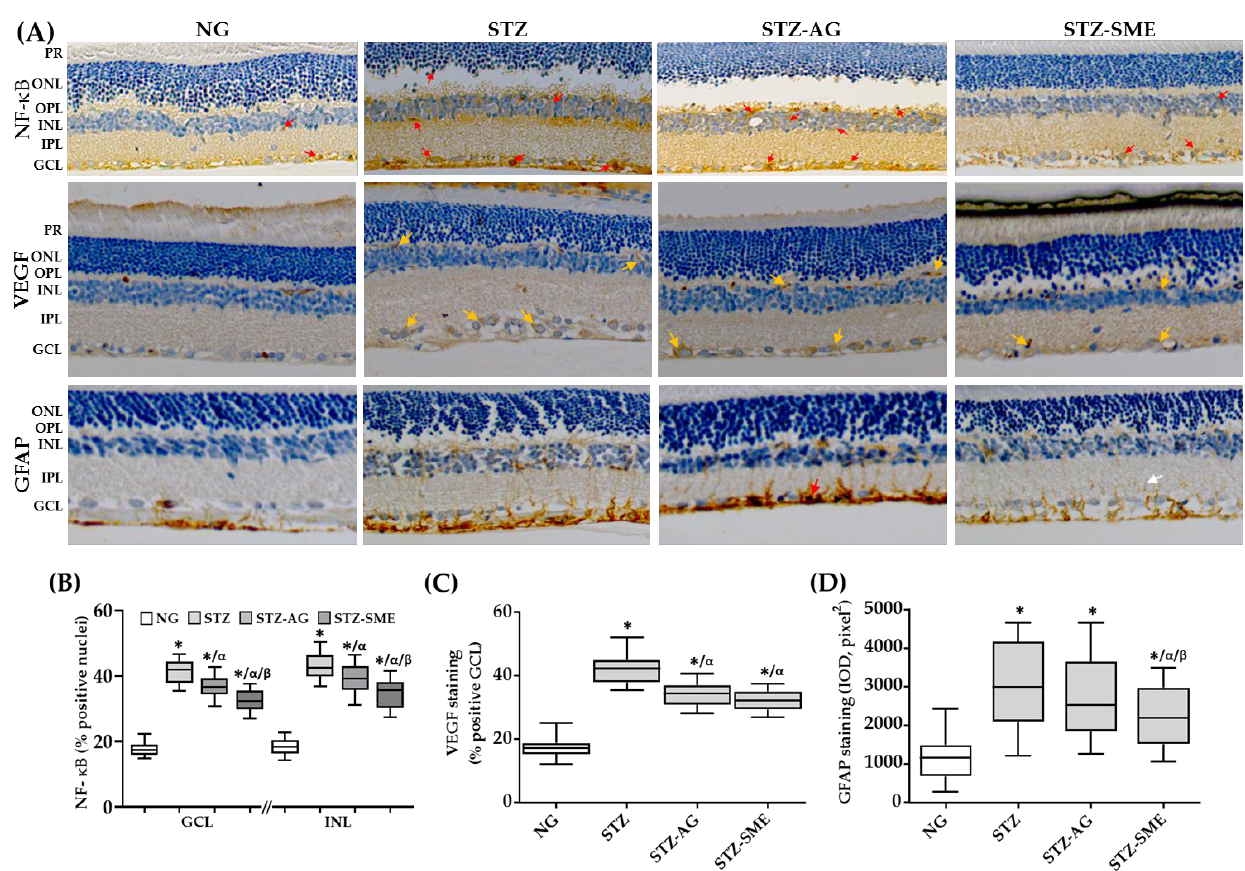
Figure 4. Effect of SME in the retinal inflammation of STZ. ( A ) Representative images of the immunostaining for nuclear NF- κ B (represented by red arrows), vascular endothelial growth factor (VEGF; represented by the yellow arrows), and glial fibrillary acidic protein (GFAP; red and white arrows indicate maximum and minimum staining intensity, respectively) in the NG, STZ, STZ-AG, and STZ-SME groups. ( B , C ) Box-and-whisker plots show the percentage of positive staining for nuclear NF- κ B (GCL, INL, and ONL) and VEGF (in the GCL), respectively. In ( D ), the IOD for GFAP staining along the retina is shown. * p < 0.01 compared to NG; α p < 0.01 compared to STZ; and β p < 0.01 compared to STZ-AG. Magnification 200×.